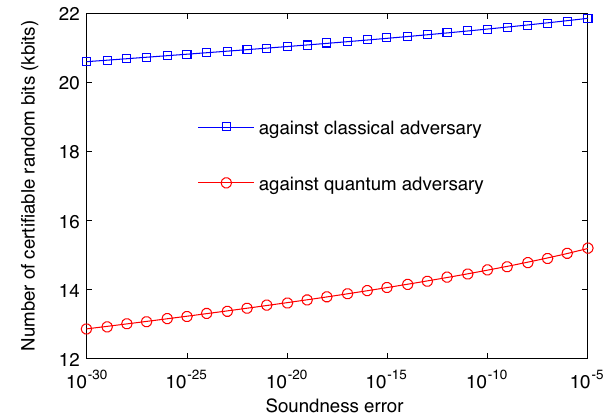
Fig. 3 Trade-off between the soundness error ϵ and the expected number of random bits certi fi able from the measurement outcomes observed every 0.1 s runtime. The results in the presence of classical and quantum side information are shown as the blue and red curves,